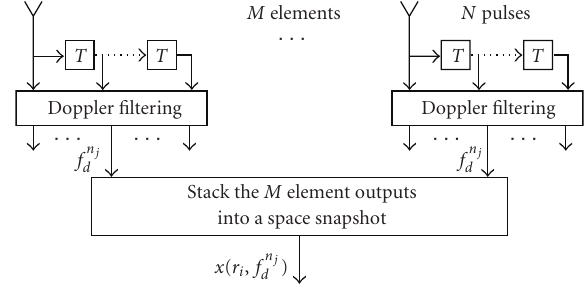
Figure 1: Representations of space snapshot for given range gate r l and Doppler frequency f n j d